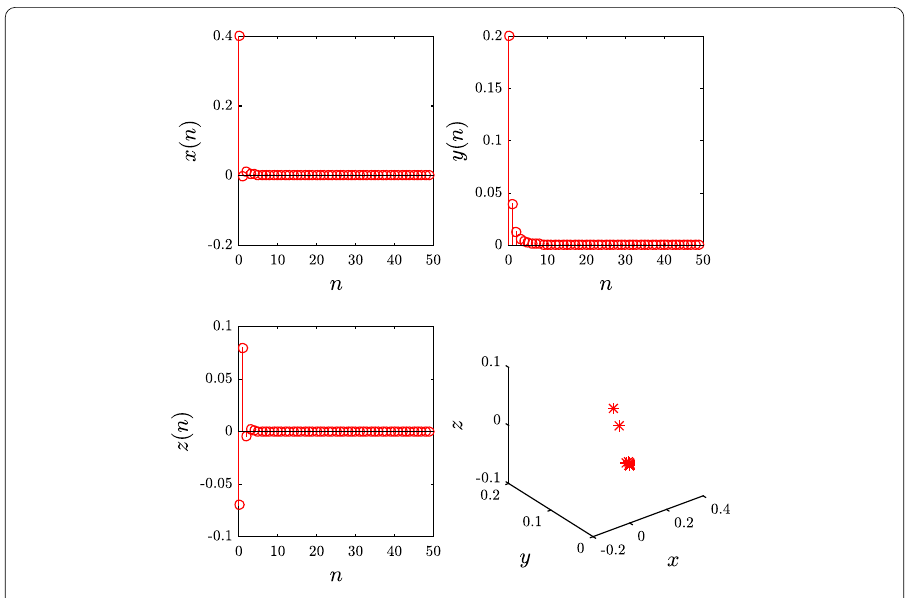
Figure 7 The time evolution of the controlled states for the fractional Stefanski